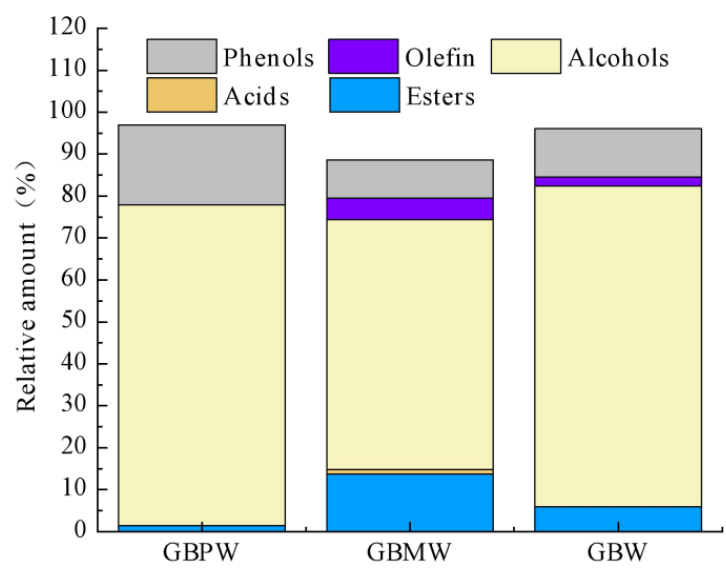
Figure 3. Relative amounts of flavor components in green banana wine samples. Table 4. ROAV value of flavor substances in green banana peel (GBPW), pulp (GBMW), and whole fruit wine (GBW)